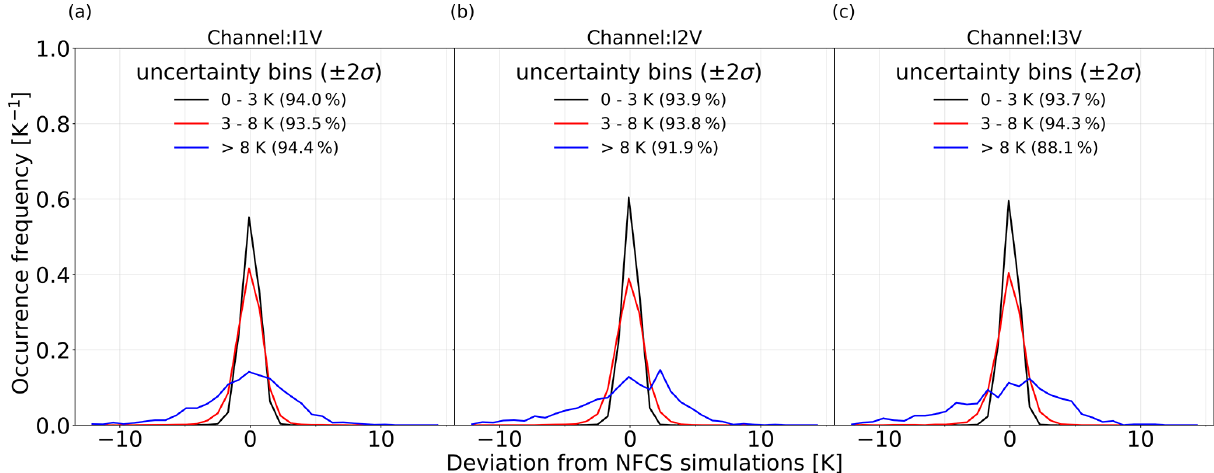
Figure 14. Distribution of errors binned according to their uncertainty. The percentage values in the parentheses represent the occurrence of true value within the ± 2 σ uncertainty range for each of the uncertainty bins. Results are from QRNN-single for channels I1V, I2V and